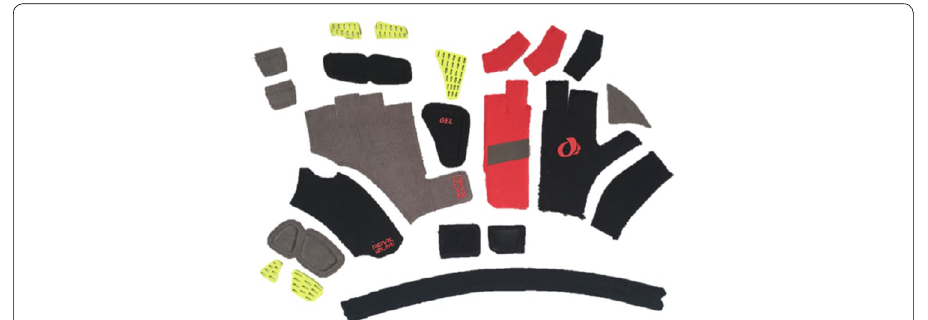
Fig. 10 Anatomy of a state-of-the-art cycling glove (Sokolowski and Hoegsted 2019)